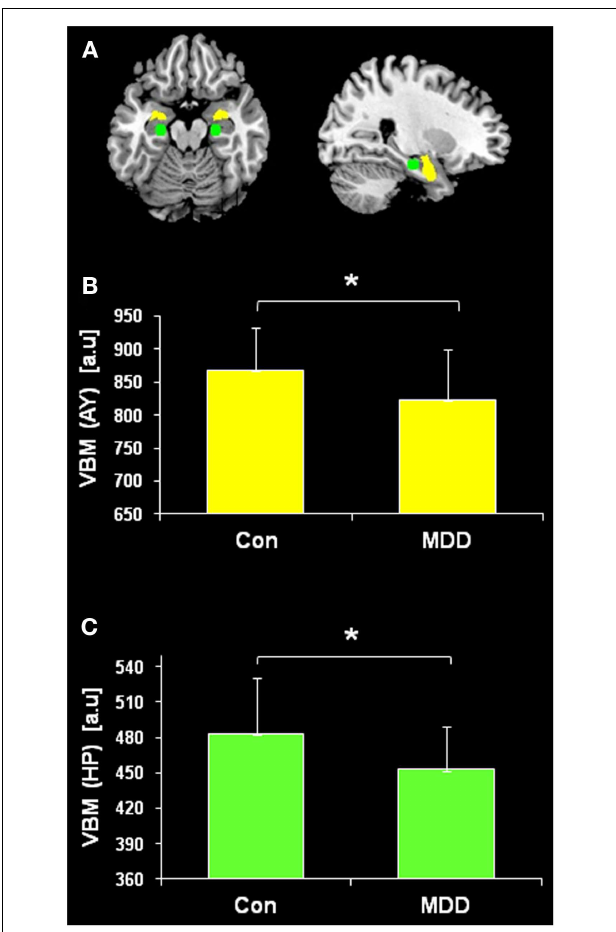
FIGURE 1 | Regional hippocampus (HP) and amygdala (AY) volumes . Seeds for the iFC analysis were positioned in the basolateral AY (yellow) and the body of HP (green). Regional voxel-based morphometry (VBM) volumes from the basolateral AY and body of HP were averaged across hemispheres and compared between patients with major depressive disorder (MDD) and healthy controls (Con) using two-sample t -tests ( p < 0.05). HP ( p = 0.011) and AY ( p = 0.019) volumes were reduced in MDD